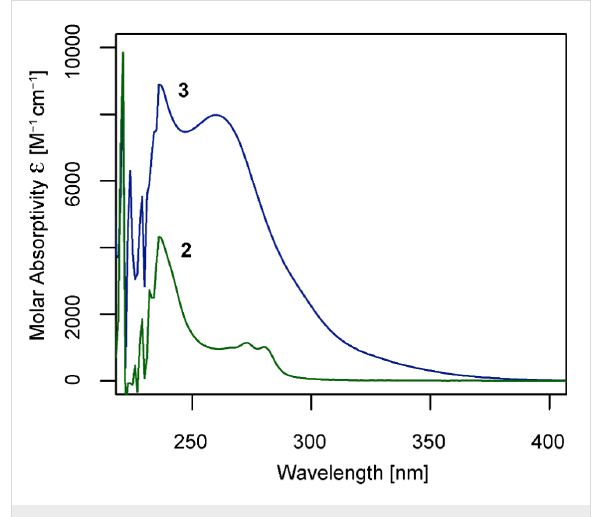
Figure 2: UV–vis spectra of reagents 2 (green) and 3 (blue) in DMSO/H 2 O